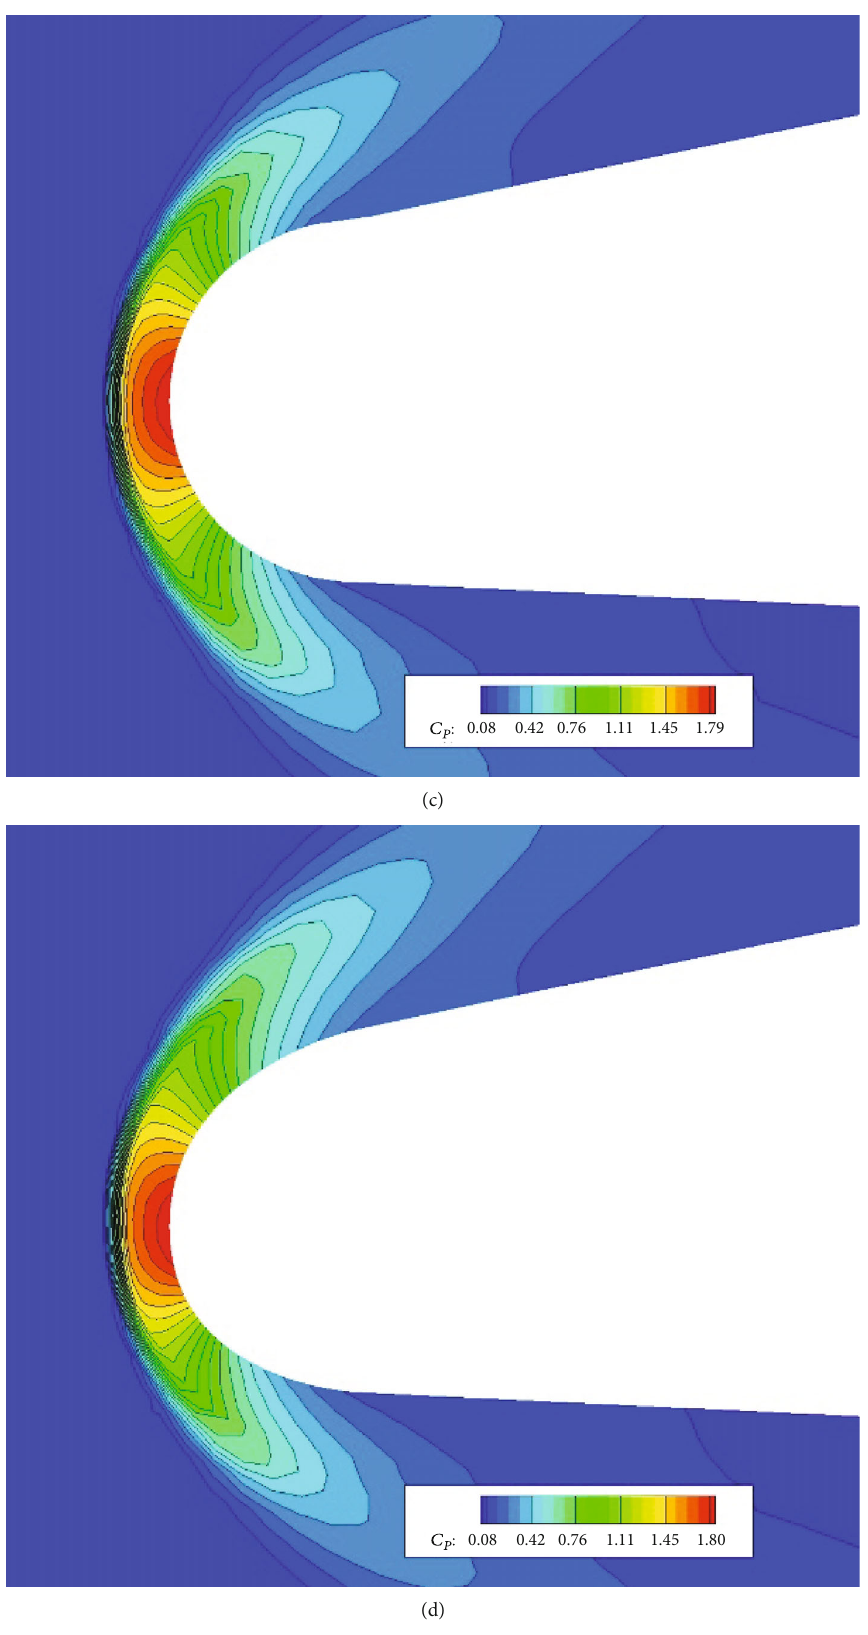
Figure 13: Contour of C on the central plane of the blunted waveriders: (a) WR1-G 0 ; (b) WR1-G 2 ; (c) WR2-G 0 ; (d) WR2-G 2 P